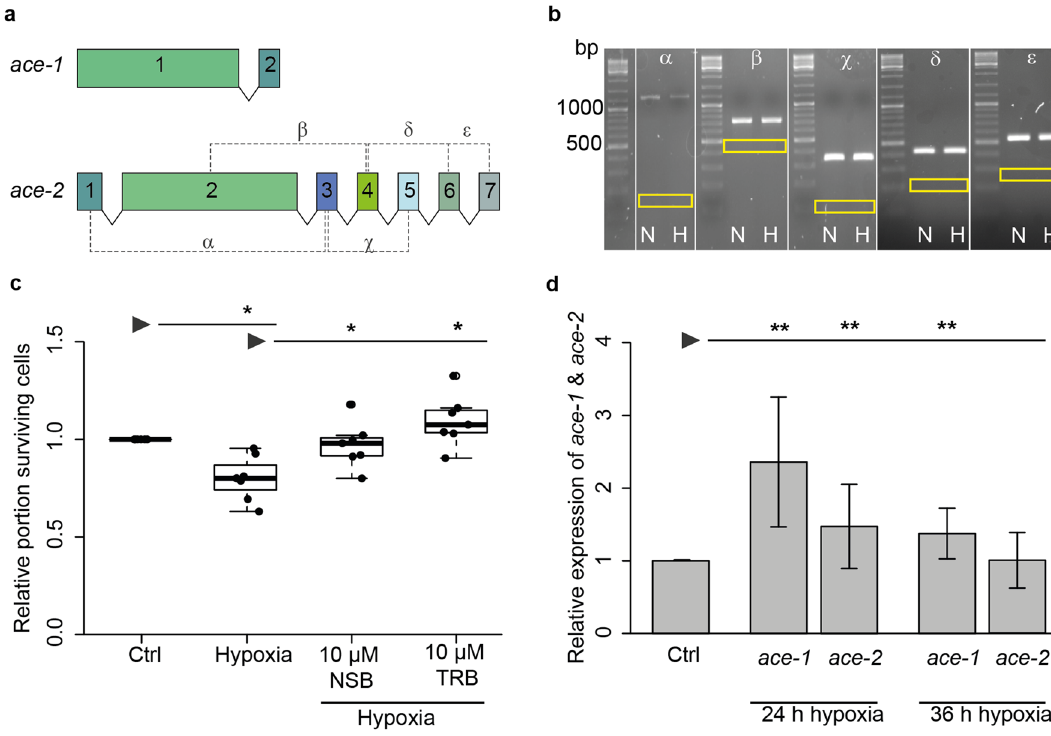
Figure 1. AChE/ ace in Tribolium castaneum neurons. ( a ) Schematic representation of T. castaneum Tc-ace-1 and Tc-ace-2 genes. Exons are represented as boxes with sizes corresponding to exon length. Introns are represented as lines that do not depict intron length. For splice variant identification exon spanning primers were designed as depicted by dashed lines. ( b ) RT-PCR analysis for splice variant identification in brains of untreated pupae ( N normoxia) and pupae after 24 h hypoxia-exposure (< 0.3% O 2 ) ( H hypoxia). Yellow boxes show the expected band size if the sandwiched exon was spliced out. Greek letters above panels correspond to primer pairs depicted in ( a ). ( c ) Relative cell survival of T. castaneum primary neurons in vitro. Cells were cultured for 5 days before being exposed to hypoxia (< 0.3% O 2 ; 36 h). Two groups were treated with AChE inhibitors NSB or TRB (each 10 µM) for the entire culturing period. Cell survival was analysed by DAPI staining and normalized to the untreated control of each experiment (set to 1). Hypoxia significantly reduces cell survival. Inhibition of AChE with either NSB or TRB completely prevent hypoxia-induced apoptosis. n = 7, 73.118 cells analyzed. Statistics with pairwise permutation test and Benjamini–Hochberg correction. ( d ) qPCR analysis of Tc-ace-1 and Tc-ace-2 transcript expression in T. castaneum brains after hypoxia-exposure. 24 h hypoxia significantly increases transcript levels of both Tc-ace-1 and Tc-ace-2 . After 36 h hypoxia only Tc-ace-1 transcript levels remain significantly elevated compared to normoxic control animals. Expression of each ace was compared and normalized to its expression in the respective control group. Data represent the mean ± SD. n = 3, rps3 and rps18 were used as housekeeping genes. Statistics with pairwise permutation test and Benjamini– Hochberg correction for multiple comparison. *p < 0.05, **p <